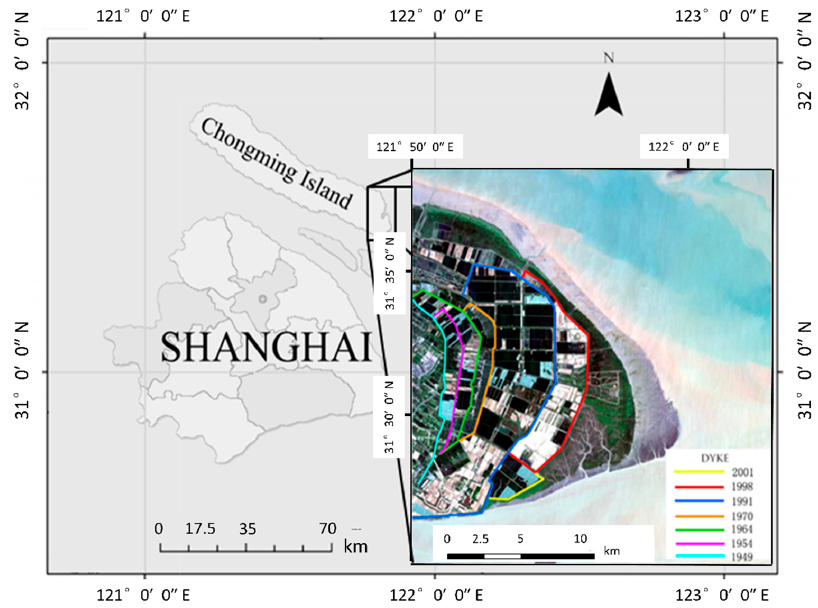
Figure 1. Study area: different line colors correspond to different years of dyke construction. Eight cloudless and terrain-corrected Landsat images of Chongming Island from 1986 to 2013 were utilized in this study (Table 1). For a number of reasons, growing season (July and August) images were selected. At this time of year, different kinds of vegetation are all at a stable stage. Meanwhile, it is easier to achieve cloud-free images due to the climatic conditions. The experimental data is comprised of six original spectral bands (band 1–5, 7 for TM and ETM+, band 2–7 for OLI) with 30 m spatial resolution.